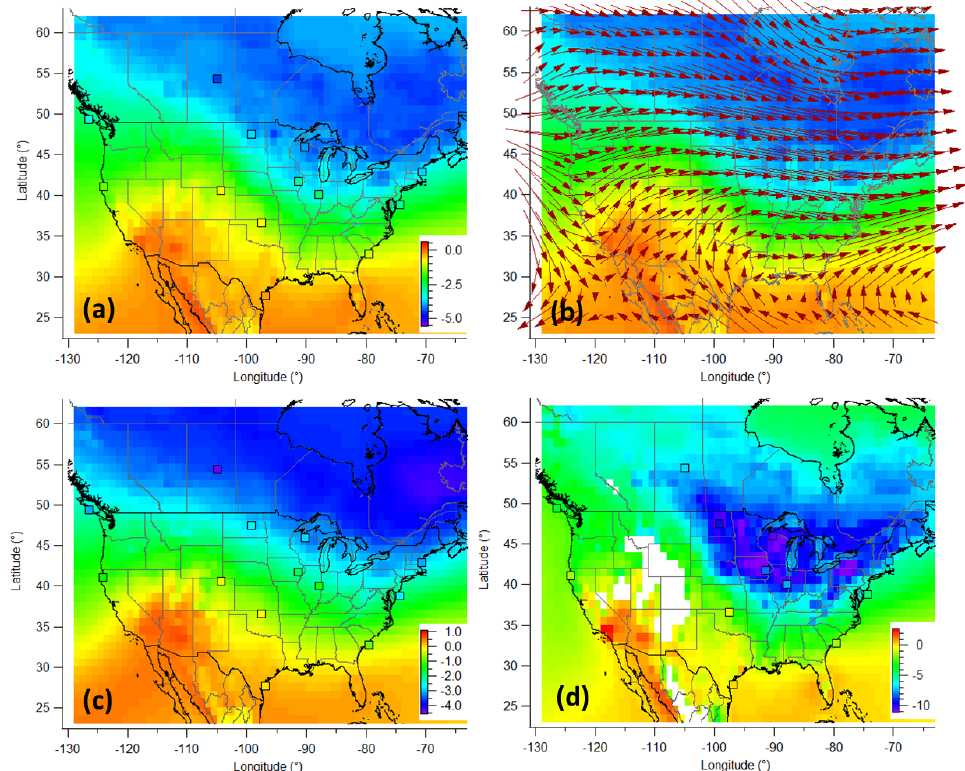
Figure 9. Long-term mean (2004–2014) for June–August total column (cid:49) XCO 2 (in ppm) from CT2015 in 1 ◦ × 1 ◦ spatial resolution with total column (cid:49) XCO 2 for 13 individual aircraft sites in squares (a) , and CT2015 column (cid:49) XCO 2 overlaid with pressure-weighted (1000 to 500hPa) mean wind vectors for the same period (b) . Panels (c) and (d) are similar to (a) , except for the free troposphere (800 to 330hPa) and lower troposphere (below 800hPa), respectively. Note the different color